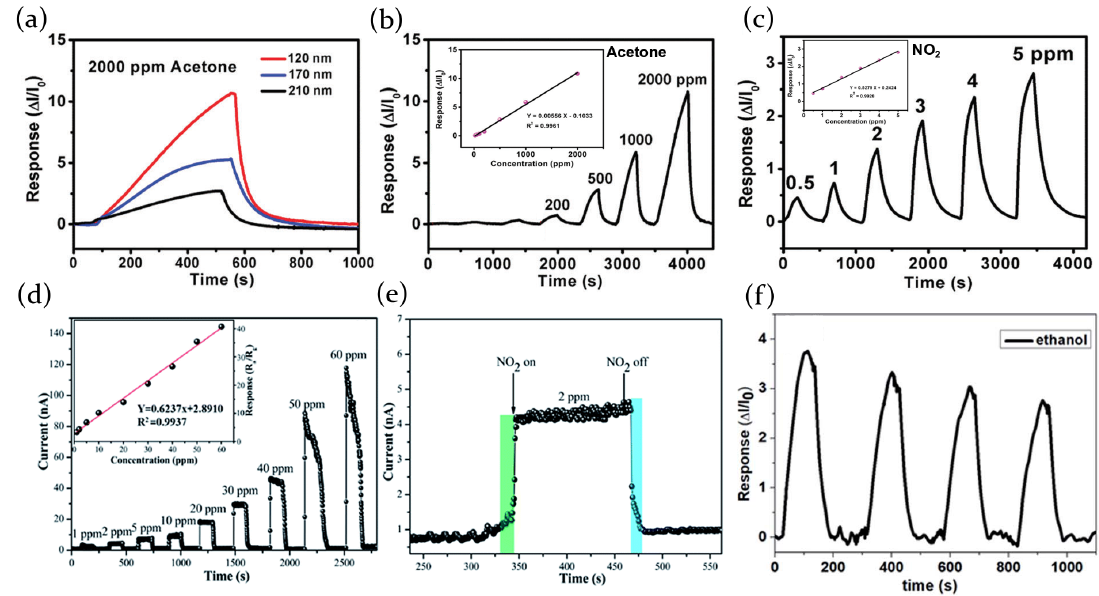
Figure 17. ( a ) Response of the SCN-organometal halide perovskites-based sensor with a 120, 170 or 210 nm-thick sensing layer when exposed to 2000 ppm of acetone. ( b ) Current response of the 120 nm thick perovskite layer to increasing acetone concentrations. Inset: linear dependence of the current response of the sensor to the gas concentration, showing an average sensitivity of 5.6 · 10 − 3 ppm − 1 . ( c ) Current response of the 120 nm thick perovskite layer to NO 2 concentrations ranging from 500 ppb to 5 ppm. Inset: linear increase of the device response to the gas concentration, resulting in an average sensitivity of 5.3 · 10 − 1 ppm − 1 . Used with the permission of the Royal Society of Chemistry, from [49]. Copyright © 2017. Permission conveyed through Copyright Clearance Center, Inc. ( d ) Response curves of the MAPbI 3 film sensor at different NO 2 concentrations (1–60 ppm). Inset: linear dependence of the resistive response to the gas concentration, resulting in an average sensibility of 0.62 ppm − 1 . ( e ) Expanded view of the on and off switches of the gas, with the corresponding response and recovery processes (green and blue shades). Adapted with permission from [87] under the terms of the Creative Commons Attribution 3.0 Unported license. Copyright © 2018, Royal Society of Chemistry. ( f ) Response–time graph of MAPbI 3 film when exposed to on/off switches of ethanol gas. Adapted with permission from [7] under a